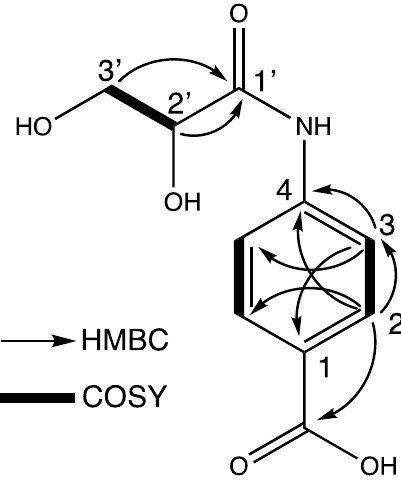
Figure 2. HMBC and COSY correlations of 1 .